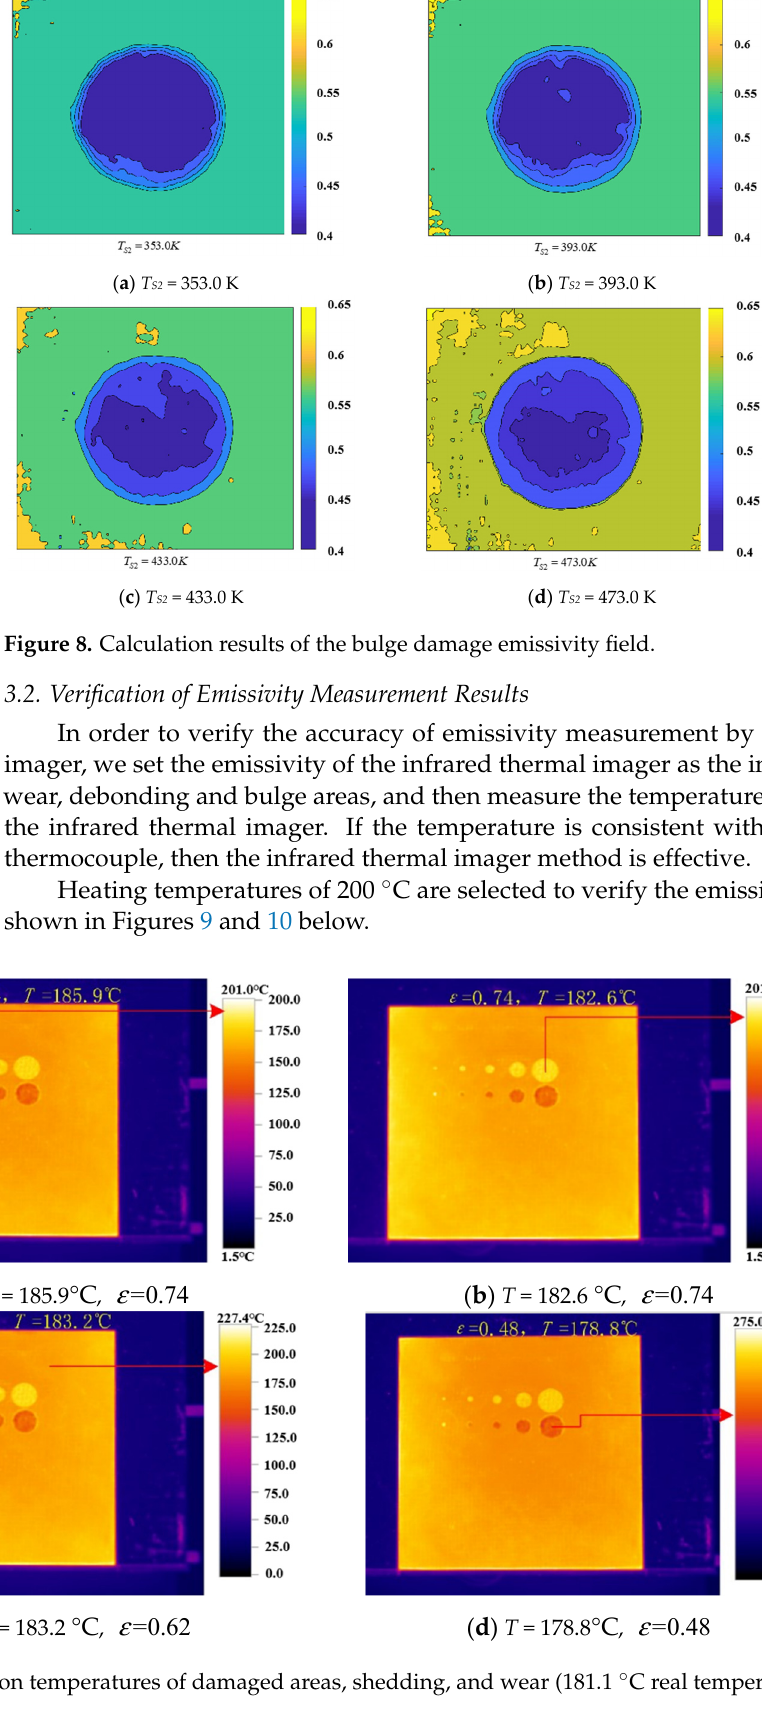
9 Figure 7. Infrared chart at 30 °C and 200 °C.